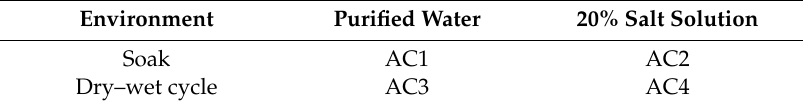
Figure 2. Asphalt scanning sample.